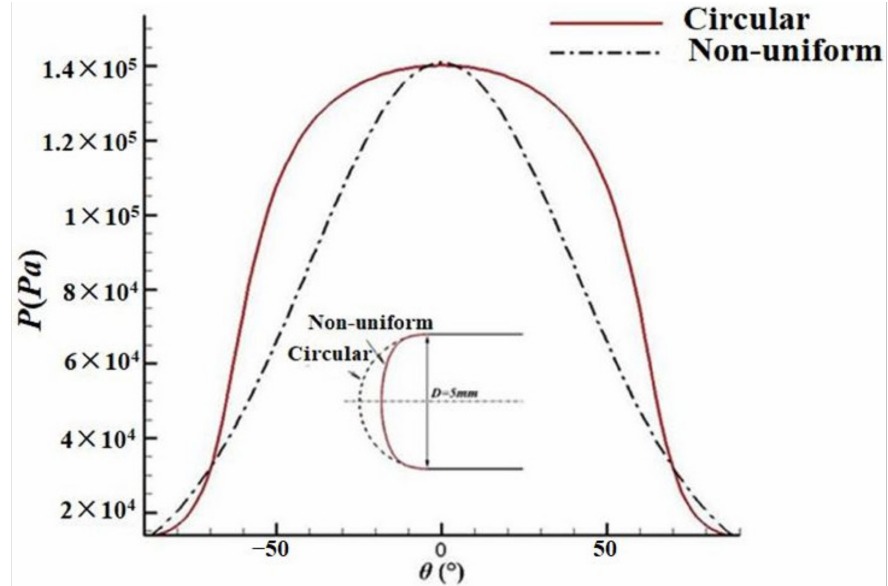
Figure 2. Pressure distribution of circular and optimal leading edge